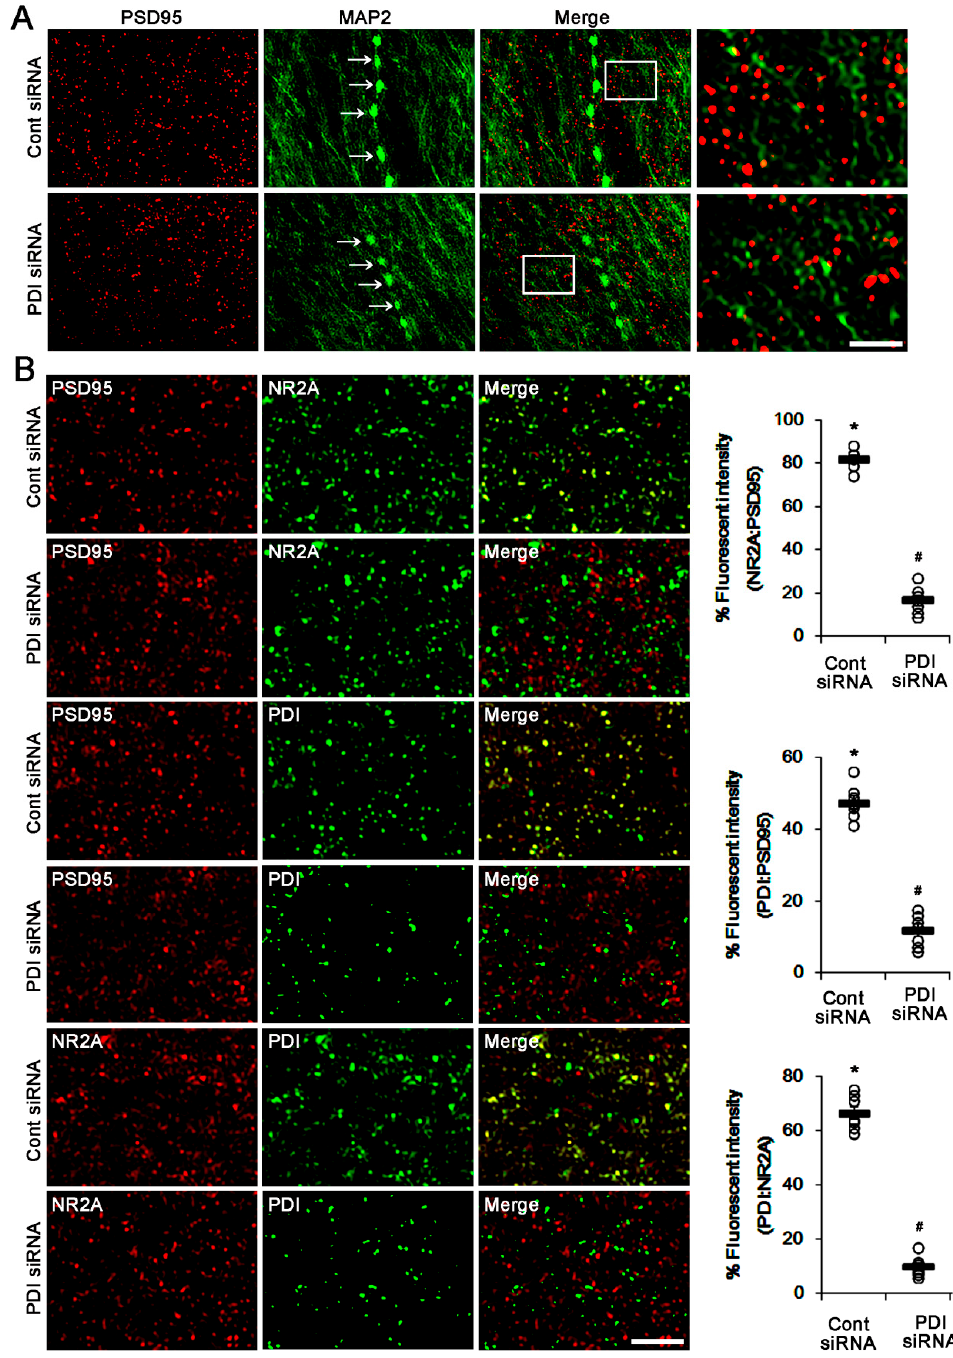
Figure 7. E ff ect of PDI knockdown on localization of PSD95, NR2A and PDI in the outer molecular layer of the upper blade of the dentate gyrus of epileptic rats. ( A ) PDI siRNA does not a ff ect the density of PSD95 puncta on MAP2-positive dendrites in epileptic rats. Arrows indicate beading (damaging) dendrite induced by seizure activity. The right panels are high magnification images for rectangles. Bar = 10 and 2.5 µ m. ( B ) The changed colocalization of PSD95, NR2A and PDI in the molecular layer of the dentate gyrus. As compared to control animals (see Figure 3B), colocalizations of NR2A:PSD95, PDI:PSD95 and PDI:NR2A are elevated in epileptic animals. PDI siRNA significantly reduced them, as compared to control siRNA. Bar = 5 µ m. The right panels indicate quantification of colocalized fluorescent intensity. Open circles indicate each individual value. Horizontal bars indicate mean value. Error bars indicate SEM ( *,# p < 0.05 vs. control animals and control siRNA, respectively, one-way ANOVA, n = 7,